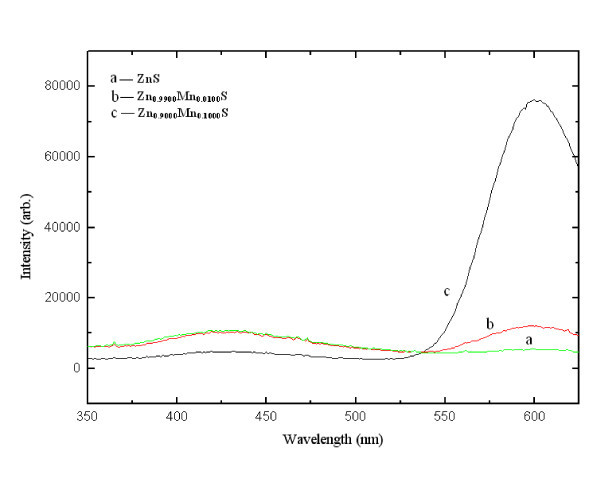
Photoluminescence spectra of Zn1-xMnxS nanocrystals.